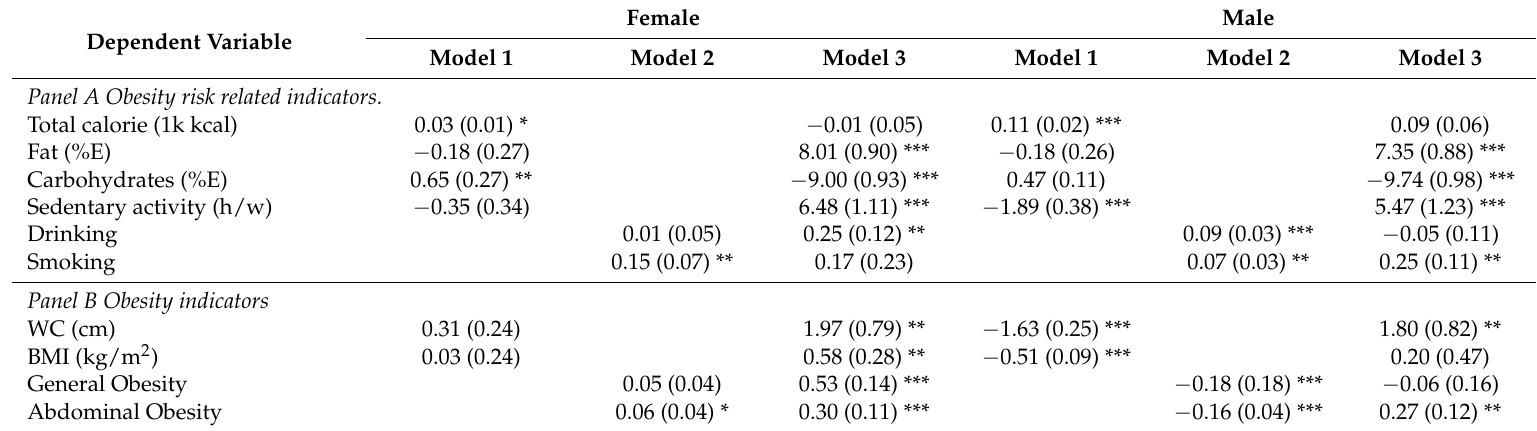
Table 3. Effects of new rural cooperative medical insurance (NRCMS) on lifestyle behavior choices and risk of obesity.